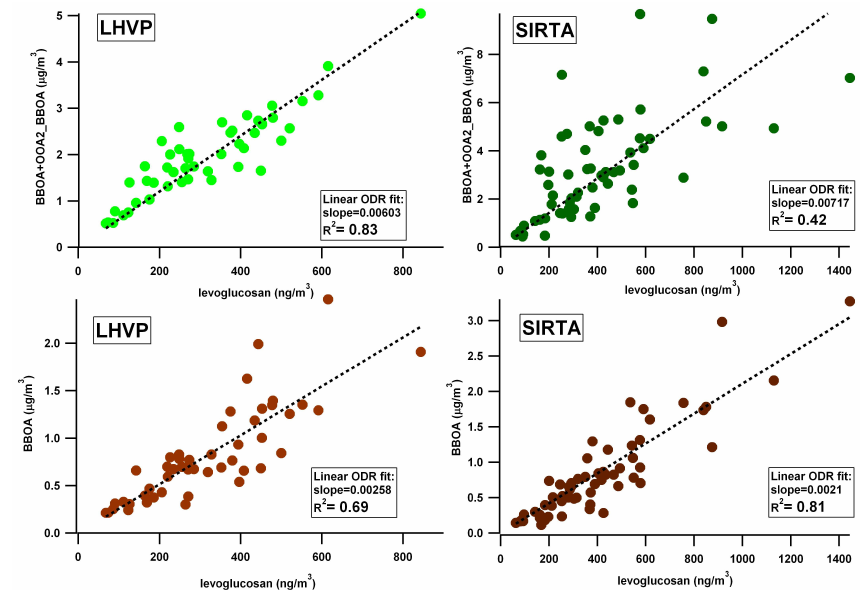
Fig. 6. Comparison of biomass burning-related PMF factors and filter measurements of levoglucosan at the LHVP and SIRTA sites.